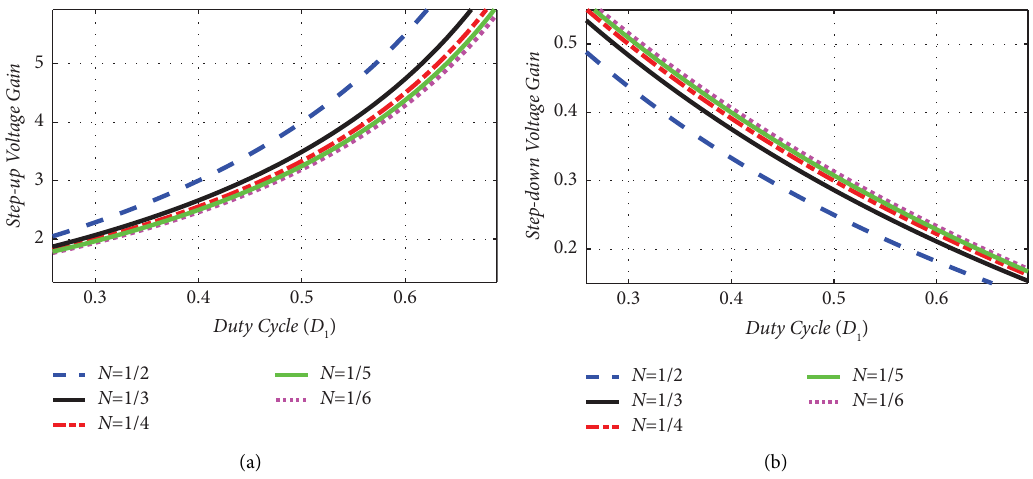
Figure 5: Voltage gains versus duty cycle: (a) step-up and (b) step-down ( D